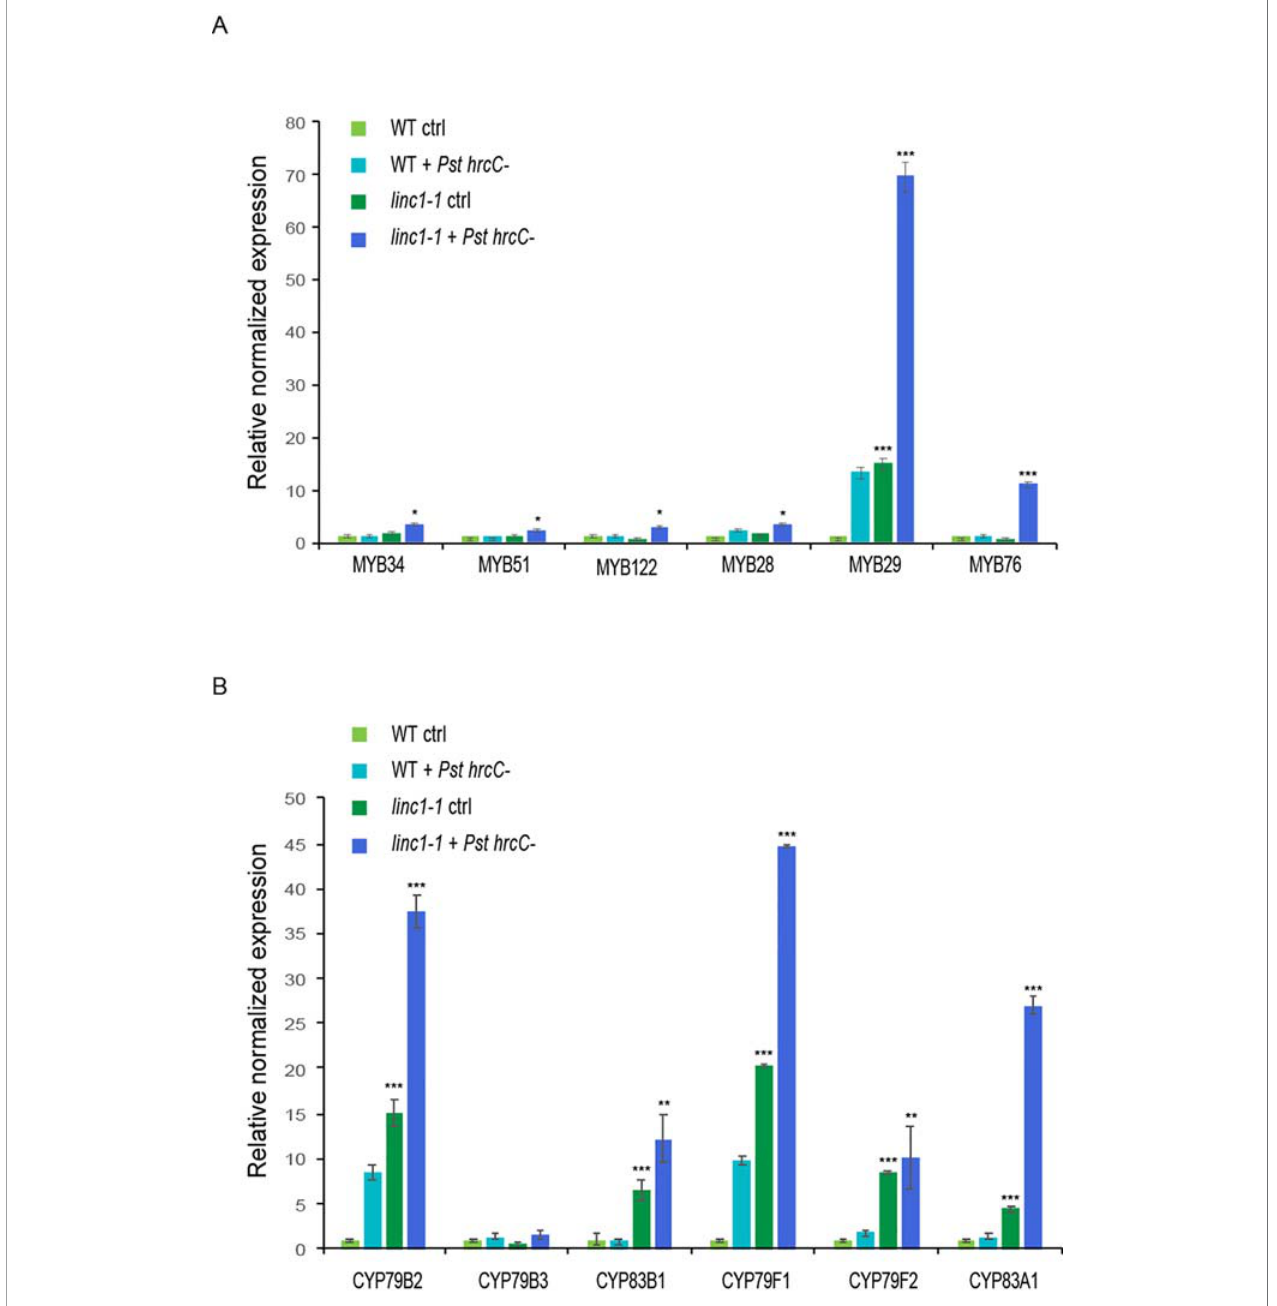
FIGURE 5 | LINC1 modulates the glucosinolate biosynthesis pathway. 14-d-old seedlings were treated with Pst hrcC- for 24 h and harvested later to isolate RNA and cDNA preparation. (A) qRT-PCR analysis of expression levels of transcription factor genes involved in the biosynthetic pathway of indolic and aliphatic glucosinolates. (B) qRT-PCR analysis of expression levels of biosynthetic genes involved in the biosynthetic pathway of indolic and aliphatic glucosinolates. Gene expression was normalized to internal control UBQ10 and actin. The data are shown in (A , B) are means from three biological replicates. Statistical signi fi cance was analyzed by two-way ANOVA, asterisk indicate signi fi cant differences compared to Wild Type, * p ≤ 0.05, ** p ≤ 0.01, *** p ≤